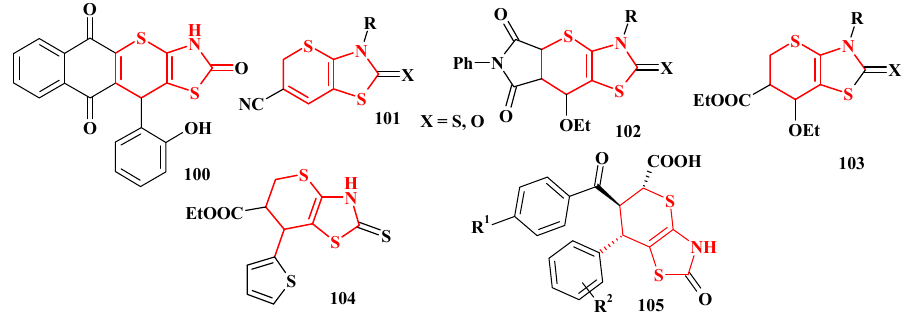
Figure 5. Thiopyrano[2,3- d ]thiazoles with antimicrobial, antifungal and antimycobacterial activities.